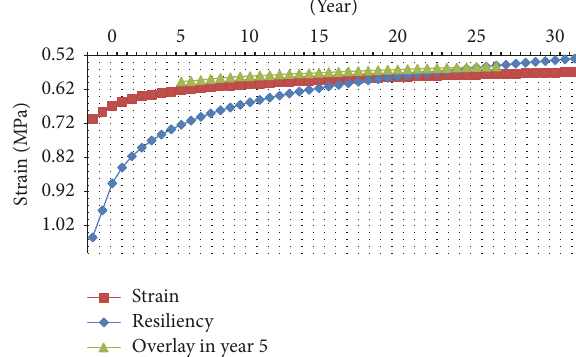
Figure 5: Radial strains before and after rehabilitation.